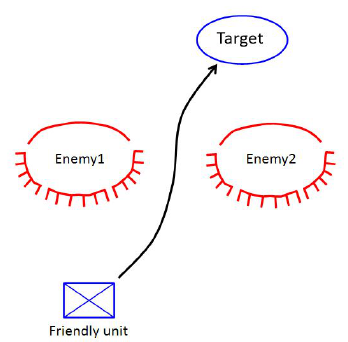
Figure 1. An example of a conceptual diagram of our